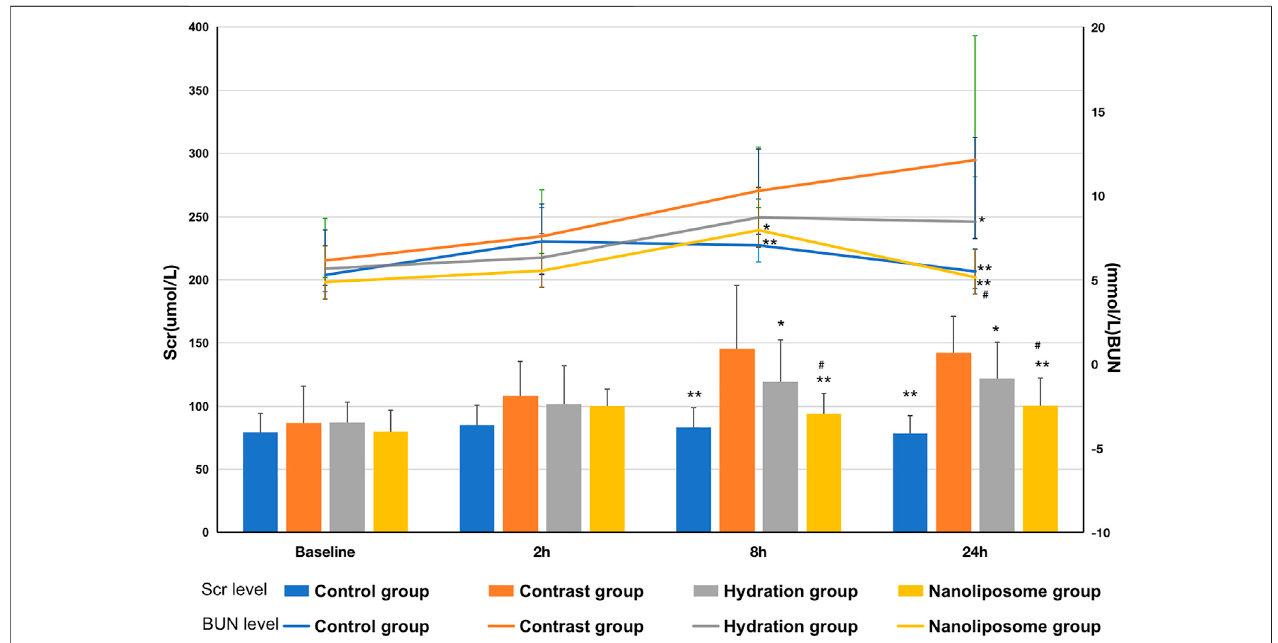
FIGURE2| ComparisonofScrandBUNinfourgroups.Scr (cid:2) Serumcreatinine;BUN (cid:2) bloodureanitrogen. Valuesareexpressed asmean ± SD.*Comparedwith thecontrastgroup, p < 0.05.**Comparedwiththecontrastgroup, p < 0.01. # Comparedwiththehydrationgroup, p < 0.05. ## Comparedwiththehydrationgroup, p < 0.01.